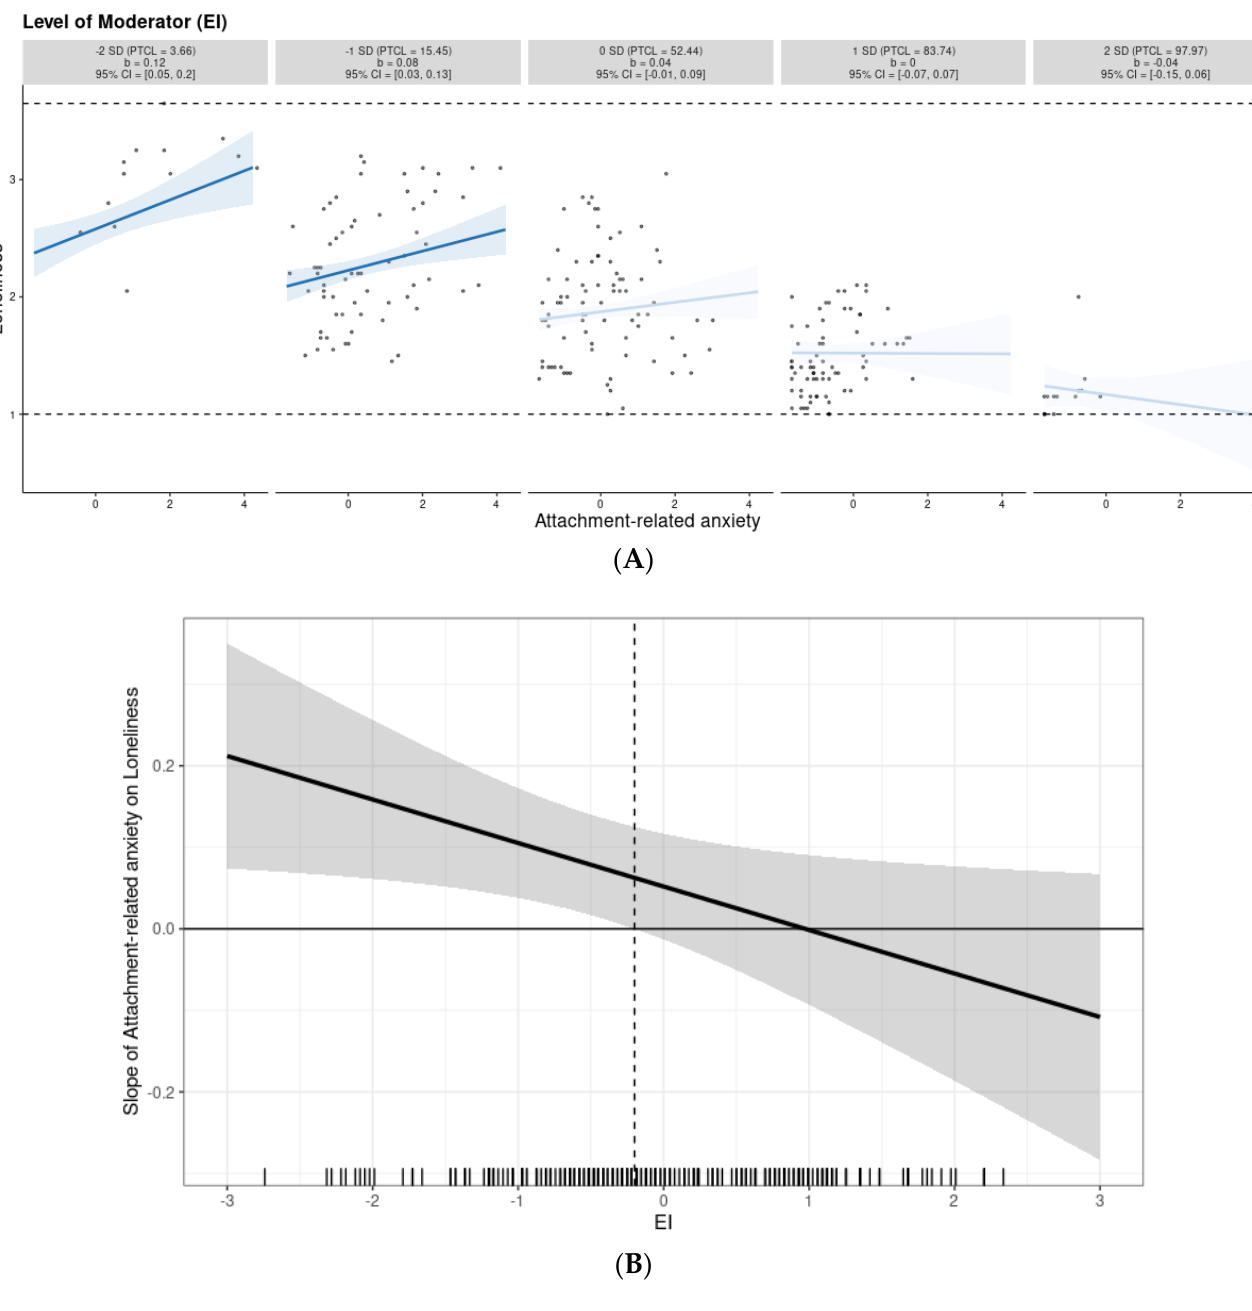
Figure 4. Graphical representation of the moderation analysis in Study 1. The interaction between attachment-related anxiety and EI in predicting loneliness (panel ( A )) and Johnson–Neyman regions representing the threshold of significance for the effect of attachment-related anxiety on loneliness at different levels of EI (panel ( B )). Note: The figures were generated using the interActive data visualization tool. The shaded regions in panel B indicate 95% confidence intervals. The effect of attachment-related anxiety on loneliness is statistically significant left of the dashed vertical line (the confidence bands there do not include zero).